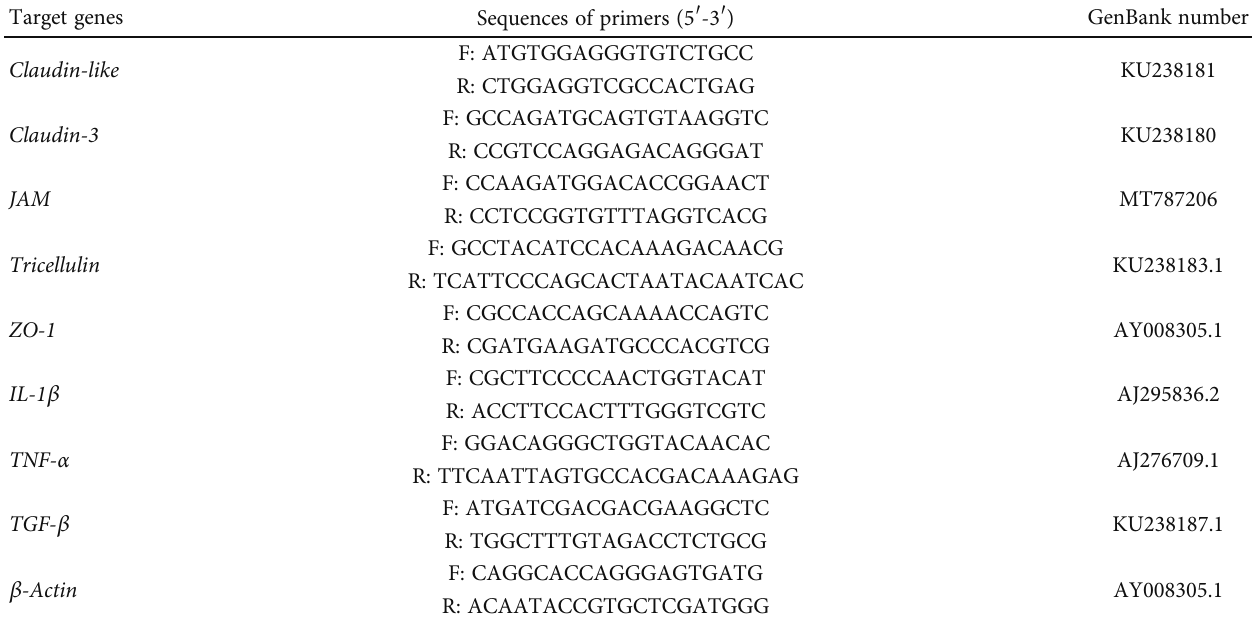
Table 4: Primers used in quantitative real-time PCR.